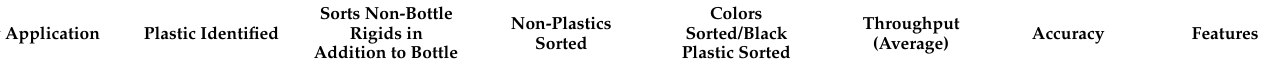
Table 4. Inventory of commercially available film